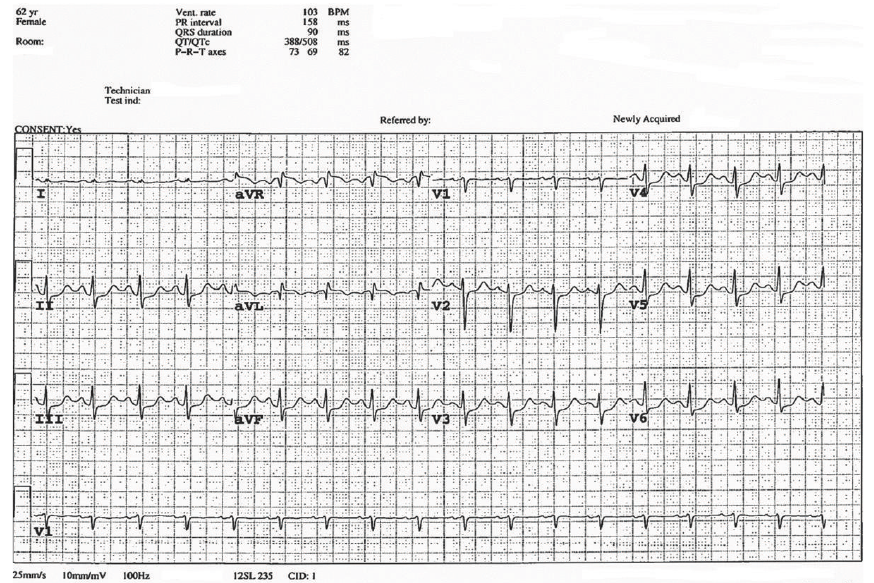
Figure 1: Initial 12-lead electrocardiogram showing diffuse ST segment depression (predominantly involving the lateral precordial and inferior leads) with minor ST elevation in lead aVL.